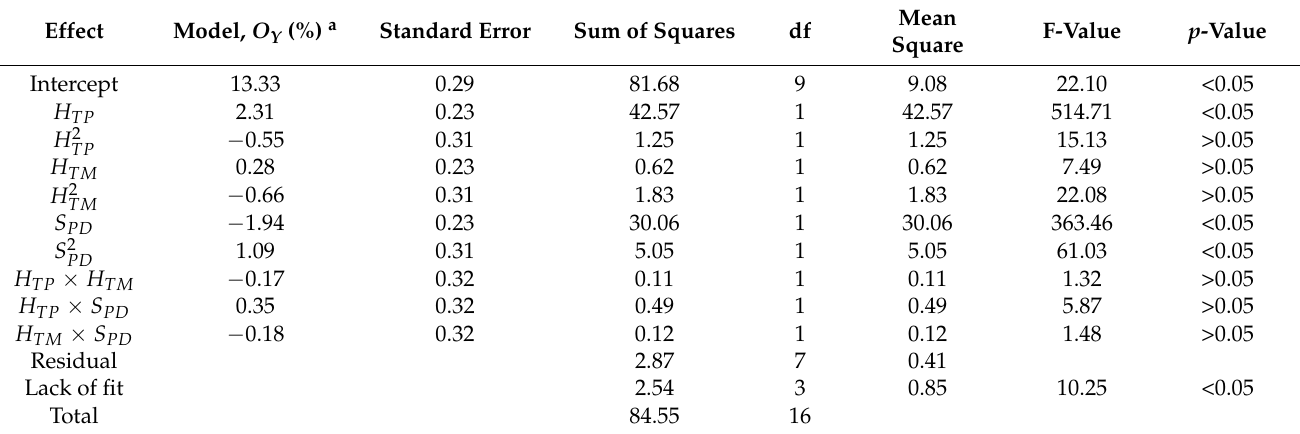
Table 6. Regression analysis of oil yield, O Y (%), under heating